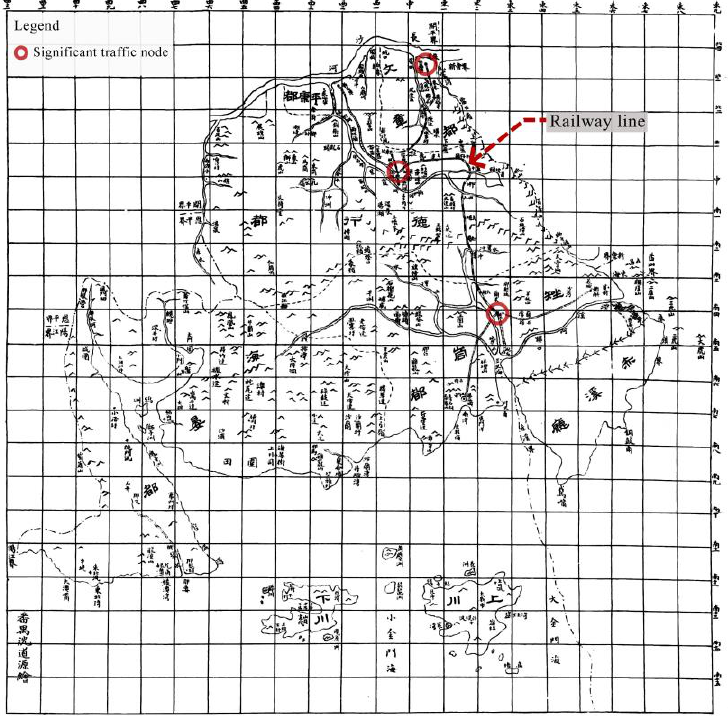
Figure 8. The Xinning Railway drawn on a map of Taishan County made during the years of Xuantong in the Qing Dynasty.